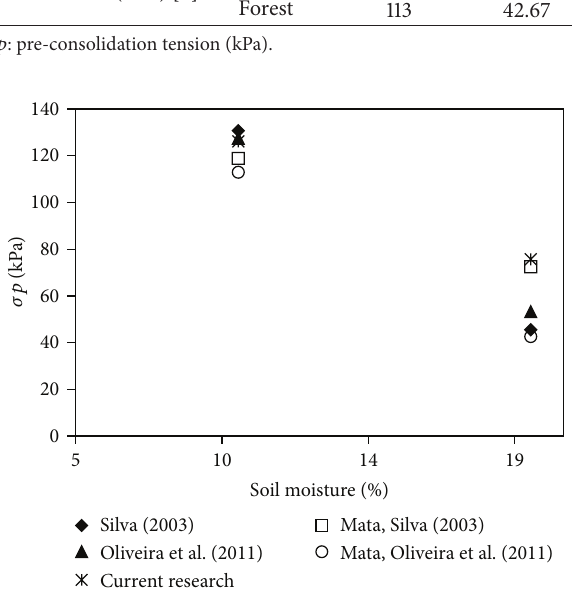
Figure 2: Dispersion of the preconsolidation tension of Ultisol presented in Table